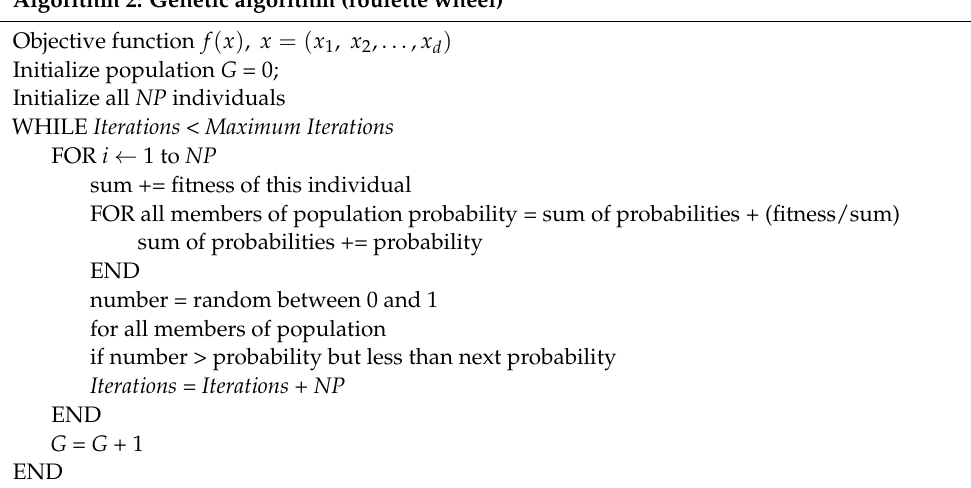
Algorithm 2: Genetic algorithm (roulette